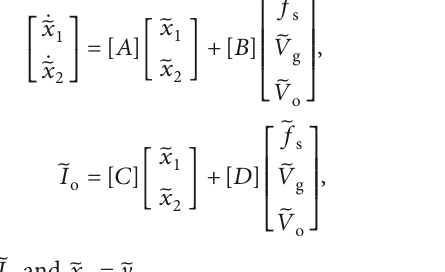
Figure 5: Current waveform during switching of SRC# [12]. (a) Example of ZCS or a small current at turnoff: switching waveforms T IGBTs. (b) Example of ZCS at turn-off for the rectifier diodes: switching waveforms D 5 and D 8